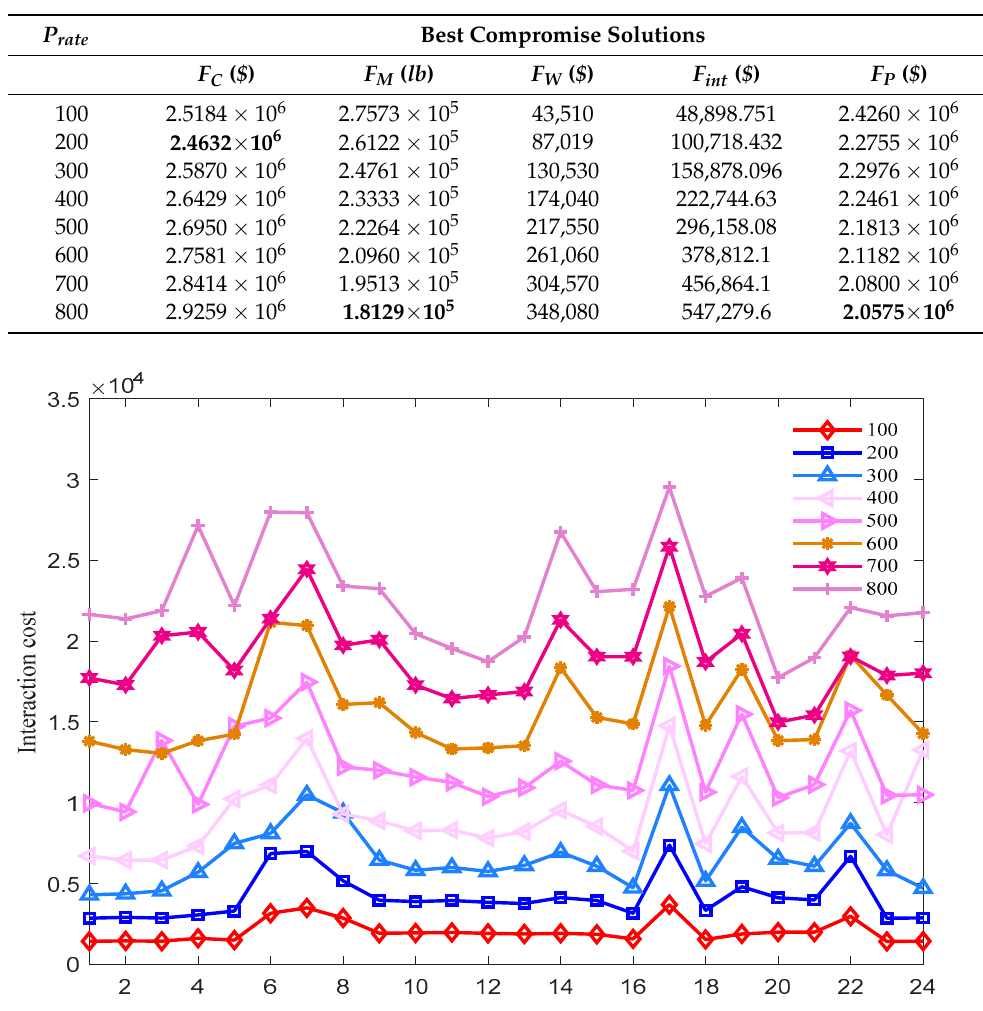
Table 15. The best compromise solutions obtained with different wind powers.